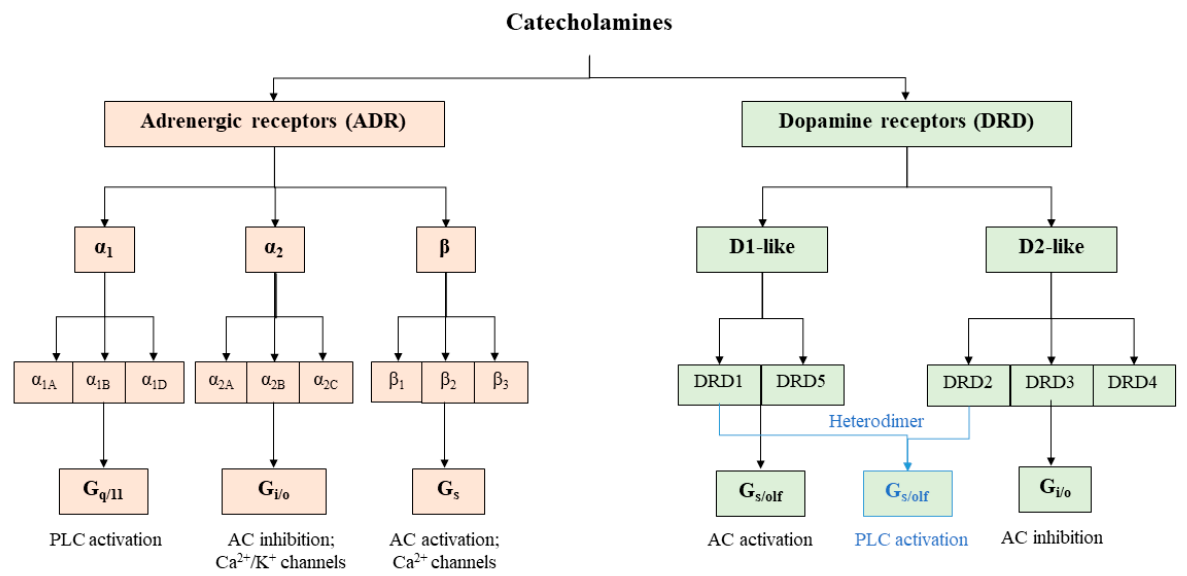
Figure 2. Catecholamines receptors. Catecholamines can activate adrenergic receptors (ADRs), composed of 9 receptors ( α 1A , α 1B , α 1D , α 2A , α 2B , α 2C , β 1 , β 2, and β 3 ), or dopamine receptors (DRDs), composed of 5 receptors (DRD1 to 5). Each receptor is coupled to G proteins alpha (q/11; i/o; s; s/olf) that can activate or inhibit effectors such as phospholipase C (PLC), adenylate cyclase (AC), or ion channels. Table 1. Expression of the dopamine receptor mRNAs in human hepatocytes in primary